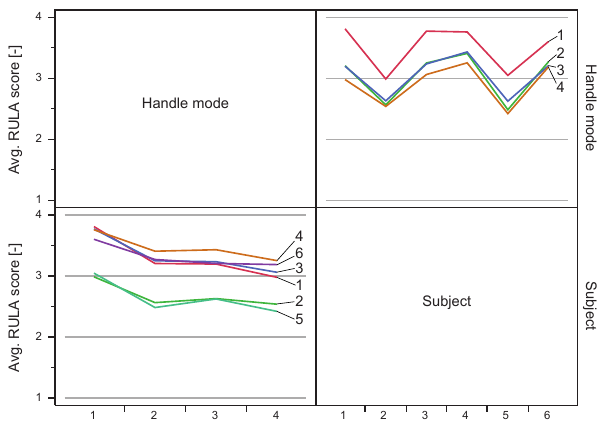
Figure 8. Interaction plot between factors “Handle mode” (fixed) and “Subject” (random) for the global performance score P